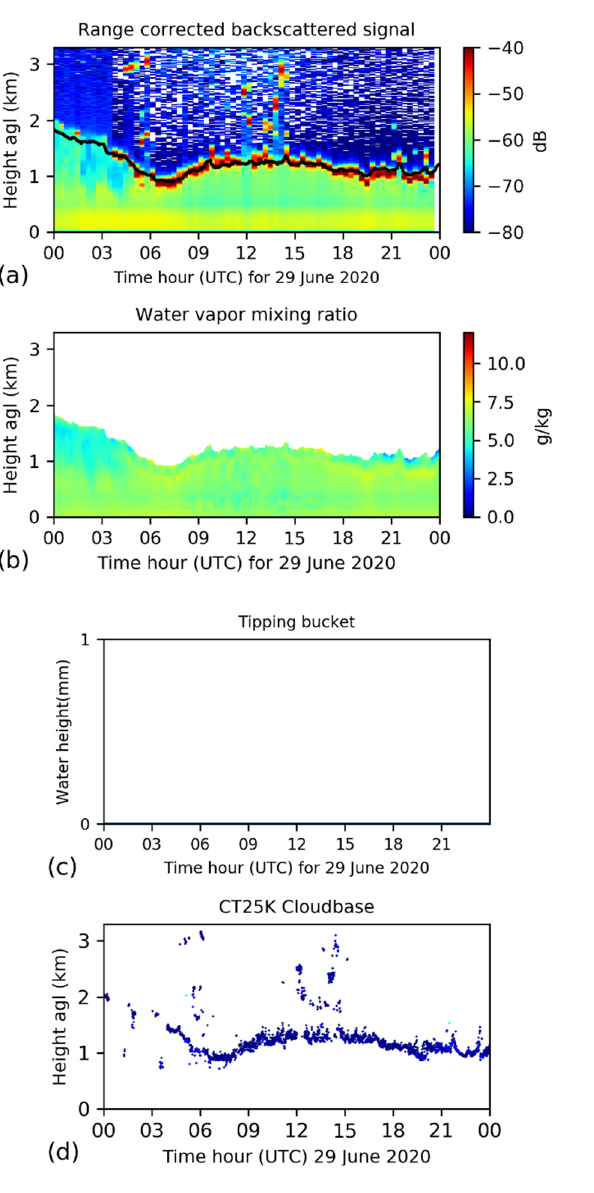
Figure 4. Contrasting examples of BB-DIAL data: left-hand side dry day (29 June) and right-hand side wet day (8 July). ( a , e ) are the range corrected backscatter (data have been thinned in time and height for plotting), the black line is the maximum trusted height given by the Vaisala algorithm. ( b , f ) are the water vapour mixing ratio (in (g/kg)). ( c ) is the tipping bucket rain gauge showing no rain on the 29 June, ( g ) is the rain intensity at the surface measured by the laser rain recorder for 8 July. ( d , h ) show cloud base height from the Vaisala CT25K ceilometer near the BB-DIAL.